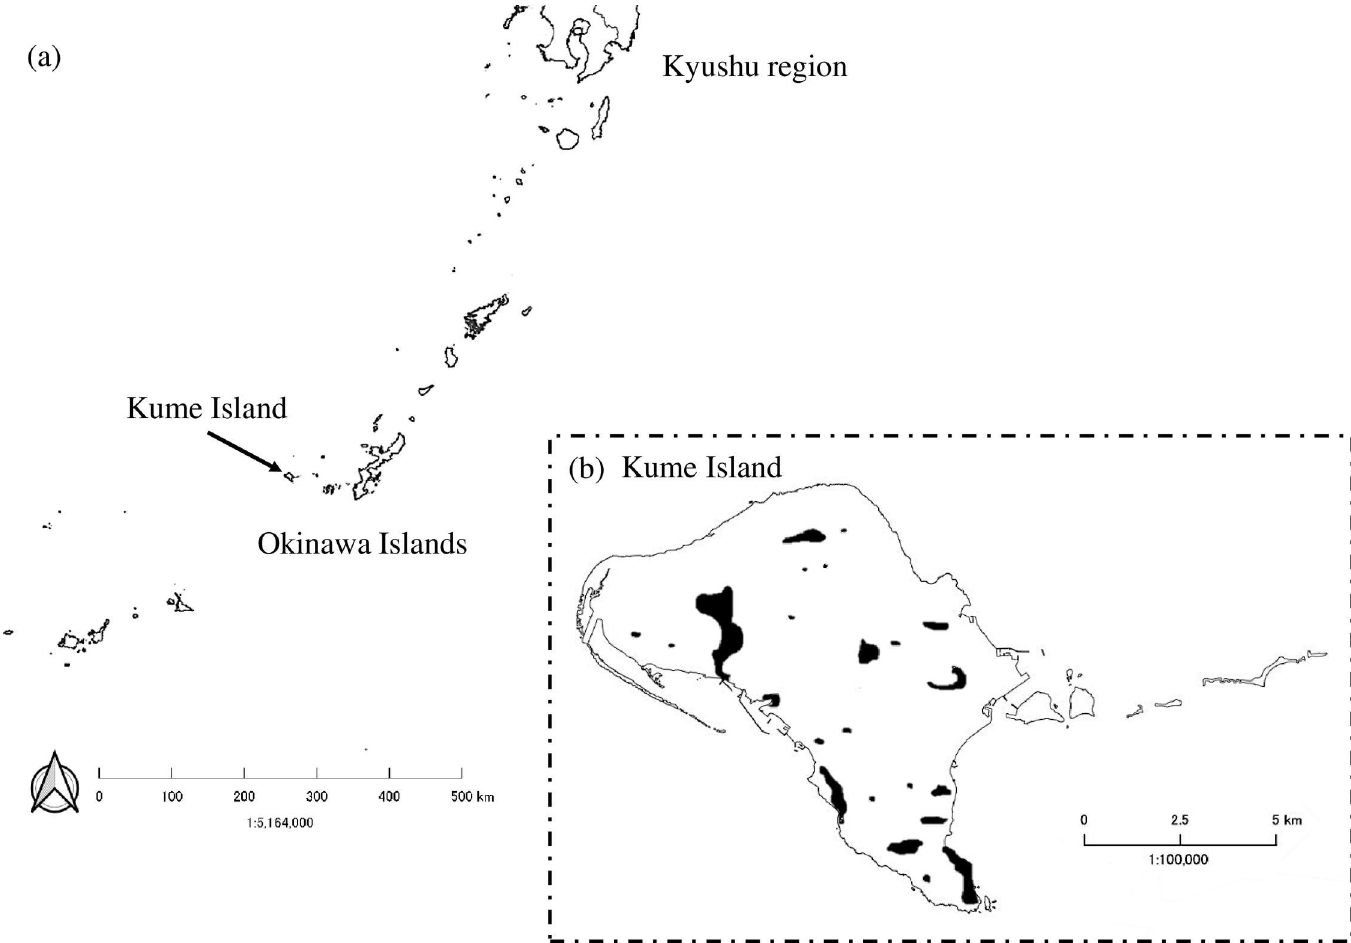
Fig 1. (a) Location of Kume Island, Okinawa, Japan. (b) Predicted distribution area of C . formicarius in Kume island (areas where male weevils have been found in trap surveys are blacked out). Created by processing a base map (Geospatial Information Authority of Japan).